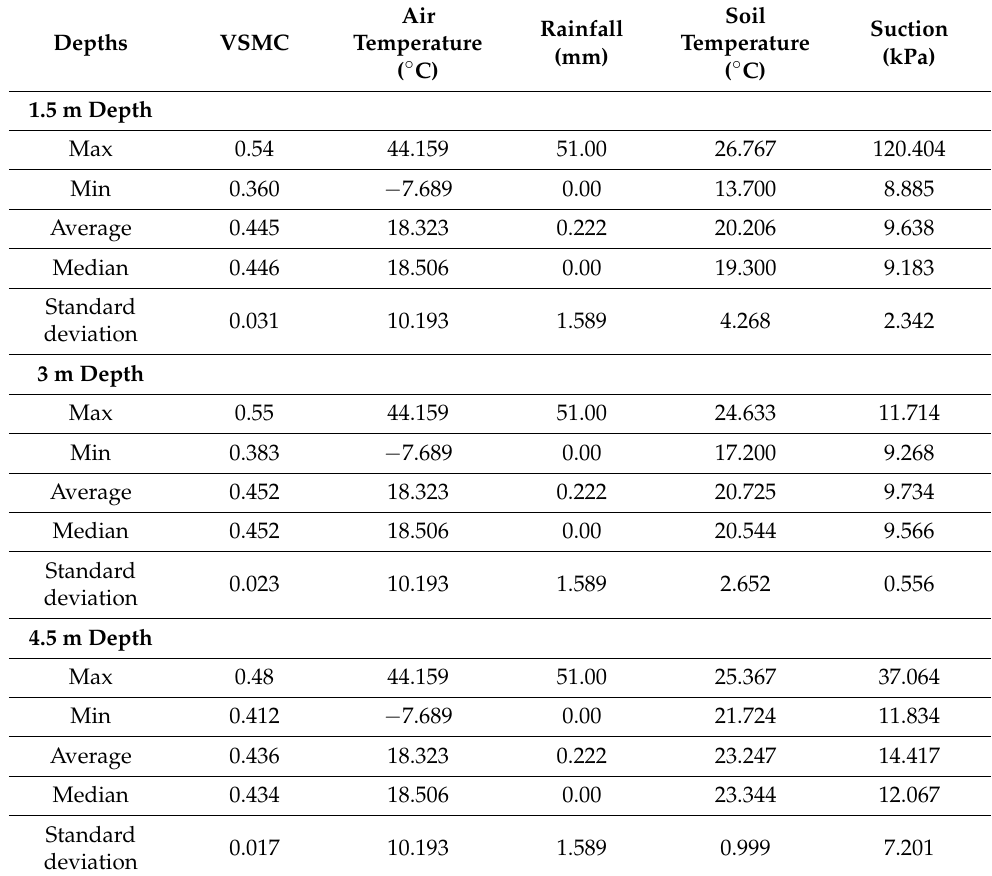
Table A4. Preliminary Detailed Statistics for the constructed dataset HWS 5.